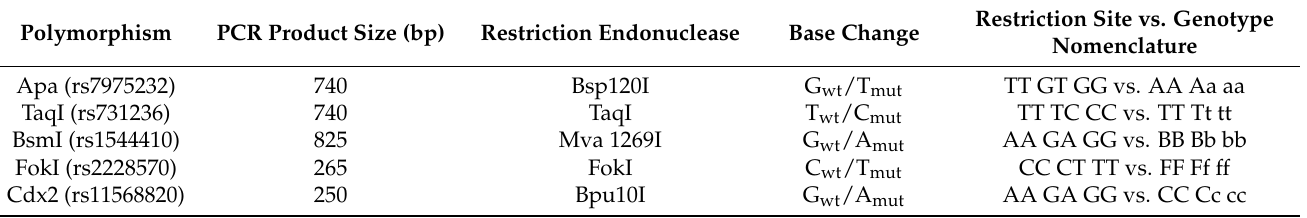
Table 1. Polymerase chain reaction restriction fragment length polymorphism (PCR-RFLP) conditions for detection of vitamin D receptor single nucleotide